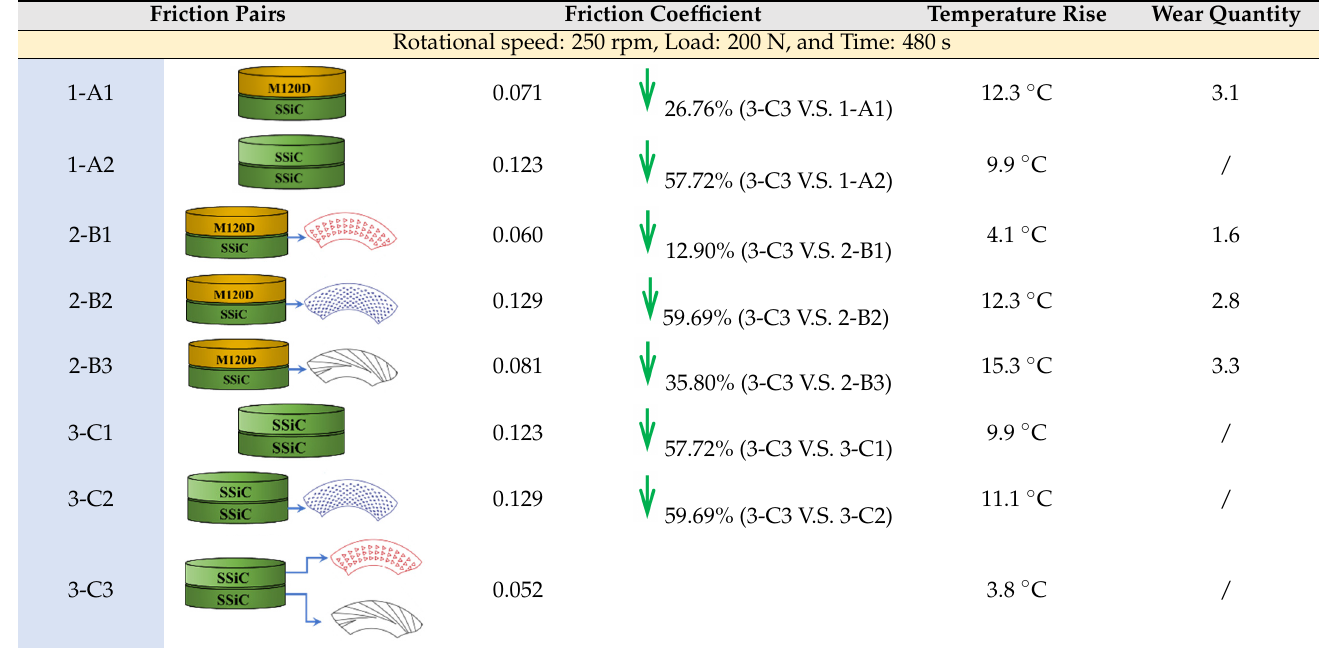
Figure 10. Real-time friction coefficient of friction pairs with bi-composite surface texture configu- rations under 250 rpm. Table 7. Comparison of tribological performance of three groups under 250 rpm and 200 N. Friction pairs